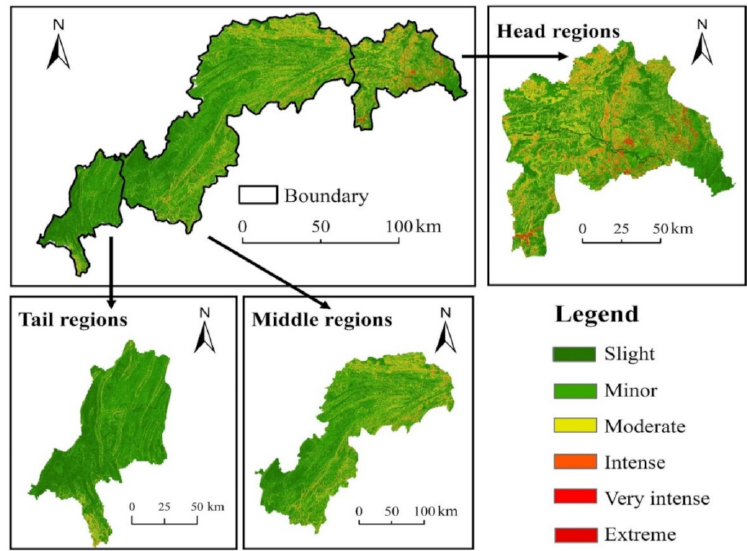
Figure 4. Spatial pattern of average soil erosion degree in the TGRA between 1990 and 2015.